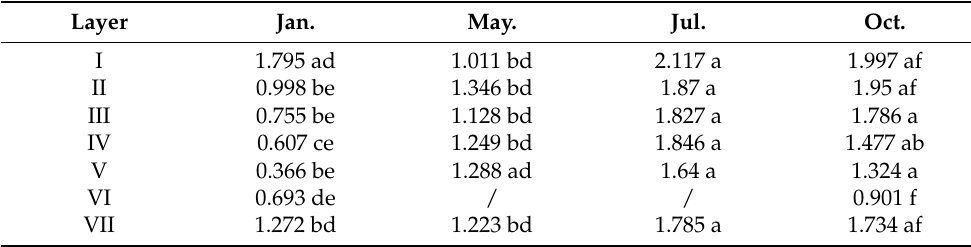
Table 3. Differences in vertical distribution of Shannon–Wiener indices of phytoplankton in the Danjiangkou Reservoir in different